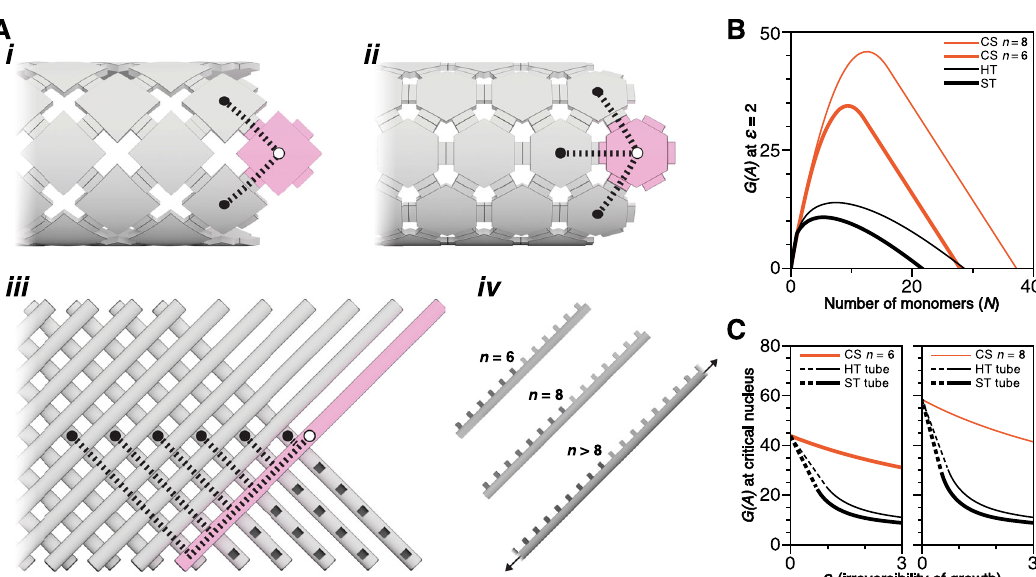
Fig. 1 Monomers with a higher coordination number (2 n ) have more sustained kinetic barriers to spontaneous nucleation under increasingly irreversible growth conditions, with a theoretical comparison of square-tile (ST) nanotubes, hexagonal-tile (HT) nanotubes, and crisscross-slat (CS) ribbons that have identical free energies G(A) for nucleation at near-reversible ε → 0 conditions. A Under near-reversible-growth conditions, incoming ST (i) and HT (ii) bind two or three nearest neighbors respectively to elongate tubes, whereas incoming CS n = 6 (iii) bind to six slats to elongate ribbons. (iv) Slats may be arbitrarily extended to any positive integer n to increase coordination number. B Free energy G(A) versus the number of N monomers in an assembly is larger for CS at irreversible ε = 2 conditions (i.e., 10 ε = 100:1 growth:shrinkage, “ high ” 1 µ M monomer). C Larger free energies of nucleation G(A) for the slats are sustained at irreversible, fast-growth, high ε conditions compared to the tiles, with 1 µ M monomer concentration. Dotted versus solid lines for ST and HT indicate where the critical nucleus transitions from a fi xed size with a constant number of monomers to where the nucleus contains increasingly fewer